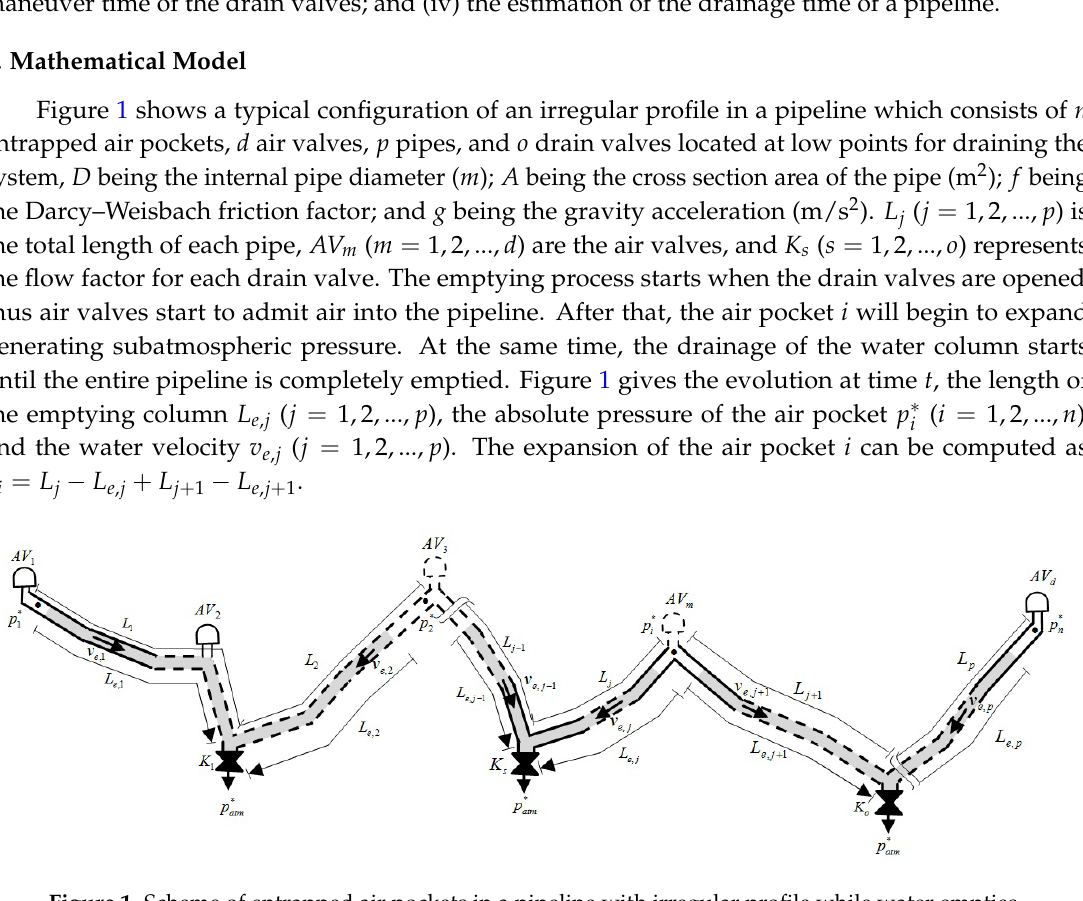
Figure 1. Scheme of entrapped air pockets in a pipeline with irregular profile while water